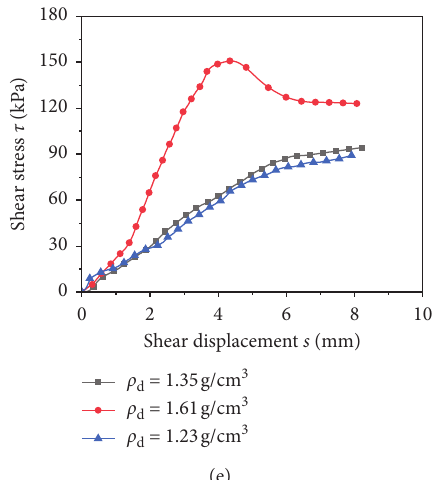
Figure 8: Shear stress versus shear displacement with different dry densities. (a) Vertical pressure 50kPa, (b) vertical pressure 100kPa, (c) vertical pressure 200kPa, (d) vertical pressure 300kPa, and (e) vertical pressure